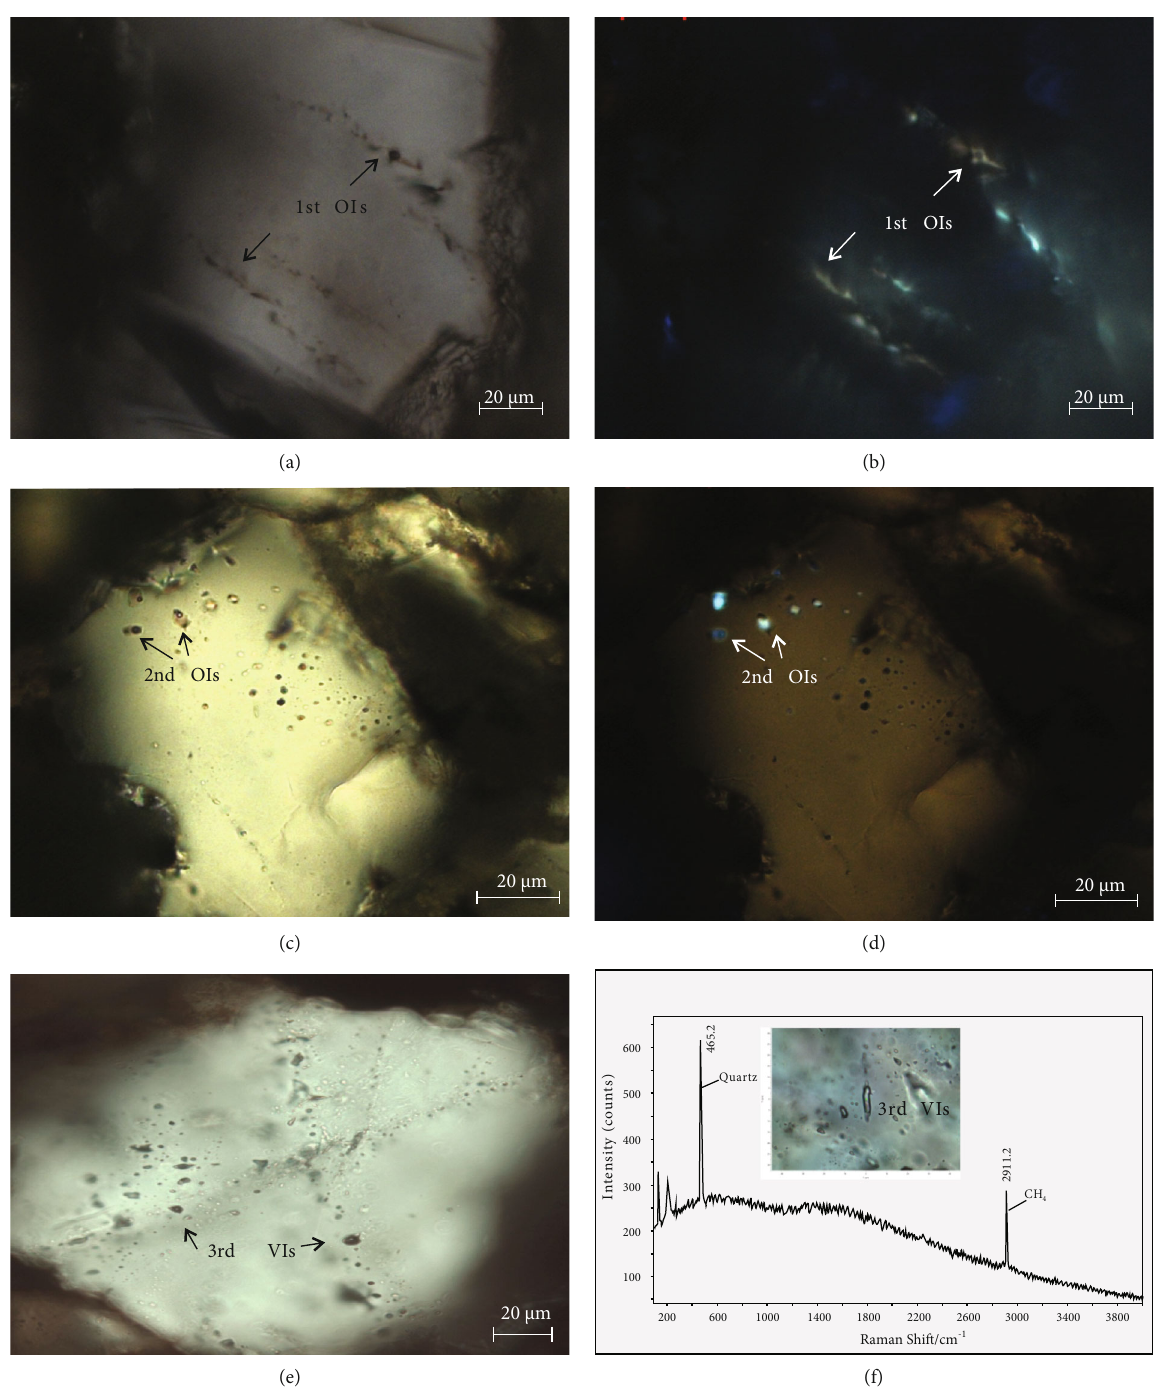
Figure 3: Representative photomicrographs of the three groups (episodes) of petroleum inclusions in the K fi eld. (a) Oil inclusions of group 1 located along annealed microfractures in a quartz grain, plane-polarized light. (b) UV fl uorescence photomicrograph of the area shown in (a). (c) Oil inclusions of group 2 located along annealed microfractures in a quartz grain, plane- polarized light. (d) UV fl uorescence photomicrograph of the area shown in (c), combined with weakly polarized light. (e) Vapor inclusions of group 3 located along annealed microfractures in a quartz grain, plane-polarized light. (f) Raman spectra of the vapor inclusion group in a quartz